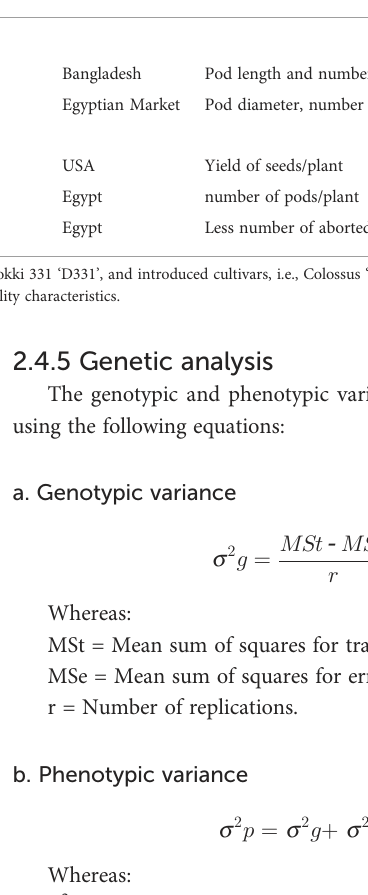
TABLE 1 List of the tested parental genotypes with their fl ower color, seed color, source and desirable traits. Parental genotypes* Flower color Seed coat color Seed eye